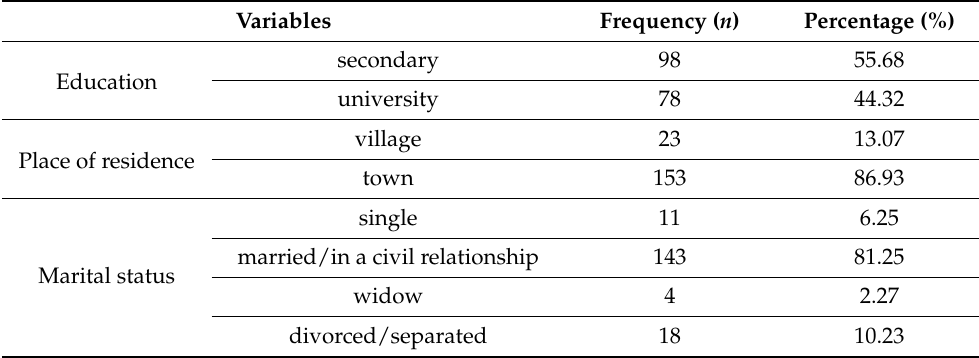
Table 1. Characterisation of the group under study ( n =